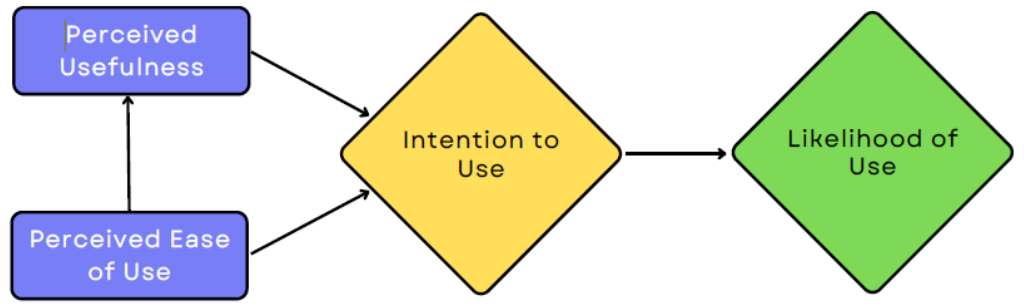
Figure 1. Overview of the Technology Acceptance Model 2 (adapted from [17]).